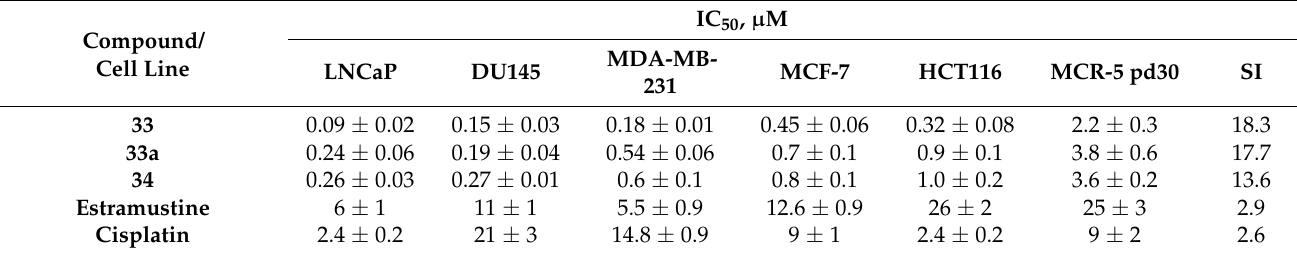
Table 18. Antiproliferative activity of prodrugs 33a, 33 and 34 on LNCaP (prostate cancer), DU145 (prostate cancer), MDA-MB-231 (triple negative breast adenocarcinoma), MCF-7 (breast cancer), and HCT-116 (colon cancer) cell lines. MCR-5 pd30 (fetal lung normal cell line) was used as a reference. Selectivity index (SI) = IC 50 MCR-5 pd30/average IC 50 (LNCaP and DU145).